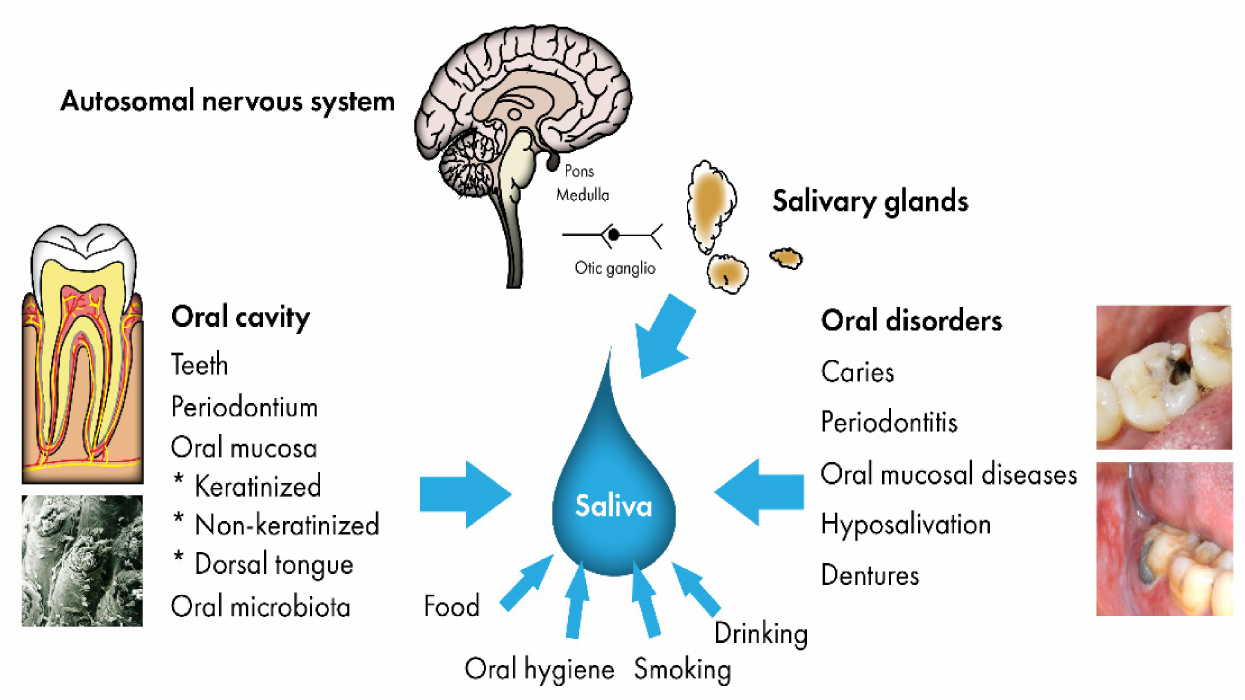
Figure 1. A summary of factors that take part in metabolic pathways in the